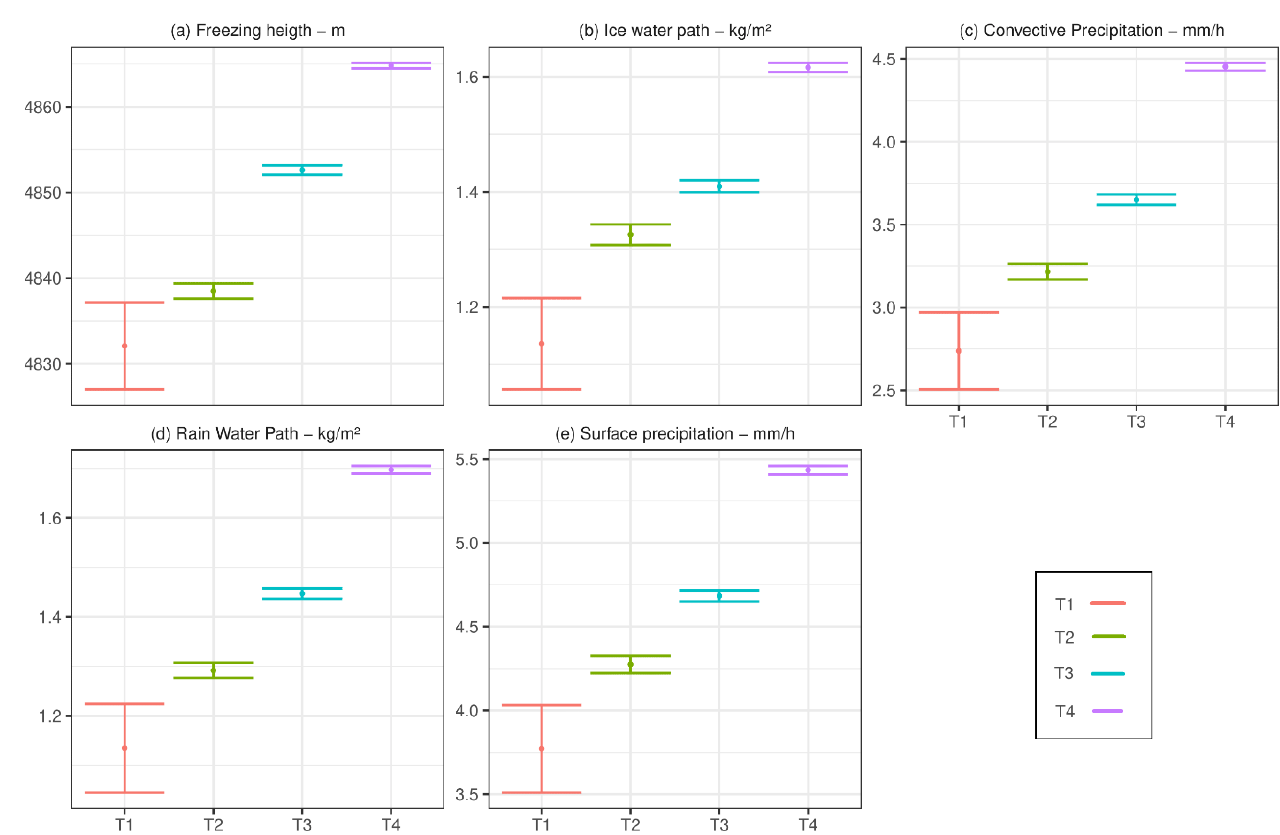
Figure 5. Mean and error bar of clouds’ microphysical properties ( a ) Freezing Level Height, ( b ) Ice Water Path, ( c ) Convective Precipitation, ( d ) Rain Water Path, ( e ) Surface Precipitation as a function of tertile classes T1 (< 0.1 flash km −2 year −1 ), T2 (between 0.1 and 2.8 flash km −2 year −1 ); T3 (between 2.8 and 6.8 flash km −2 year −1 ) and T4 (above 6.8 flash km −2 year −1 ).